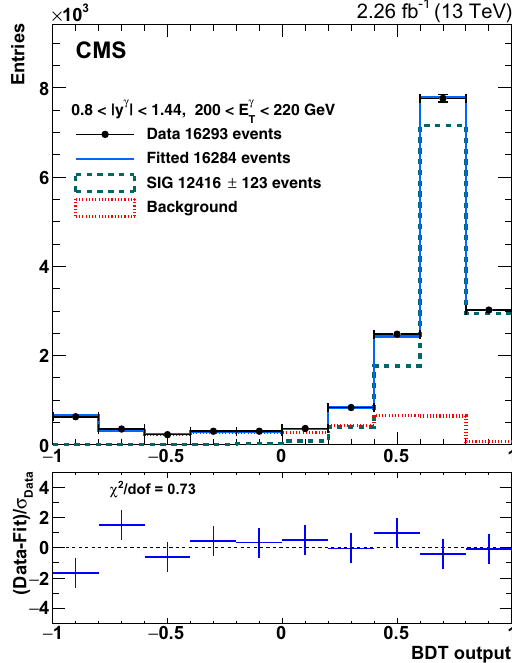
Fig. 2 Distributions of the BDT output for an EB (left) and an EE (right) bin with photon E T between 200 and 220GeV and | y jet | < 1 . 5. The points represent data, and the solid histograms, approaching the